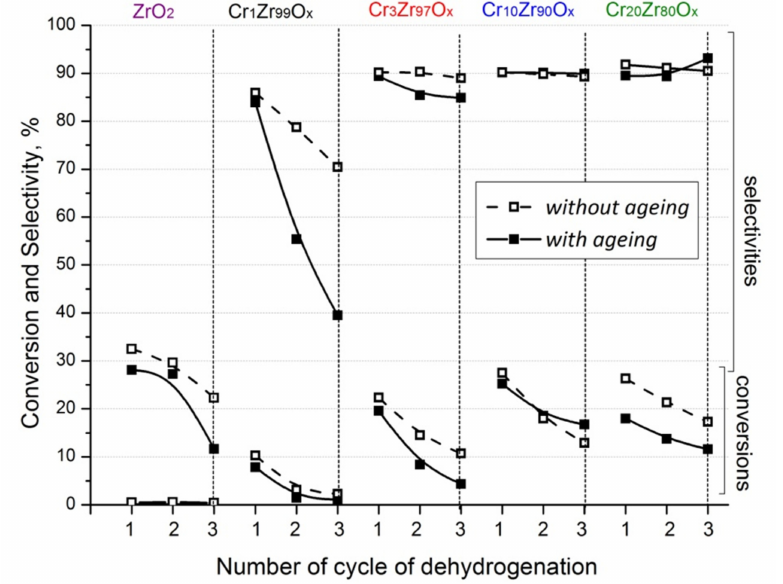
Figure 5. Catalytic results for obtained samples in